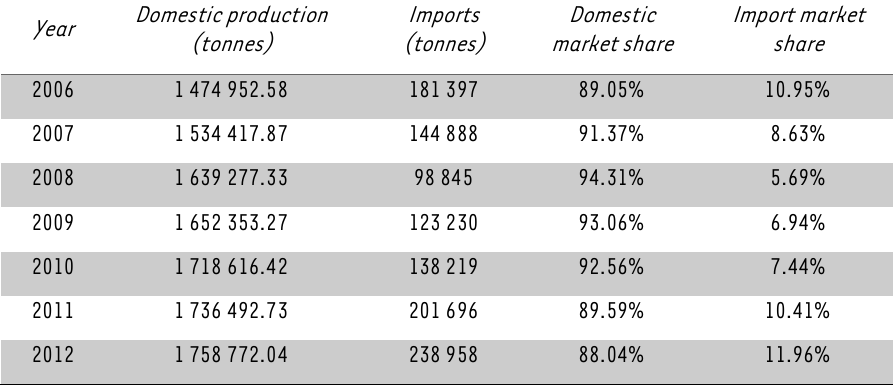
TABLE 3: Comparison of domestic production and imports of